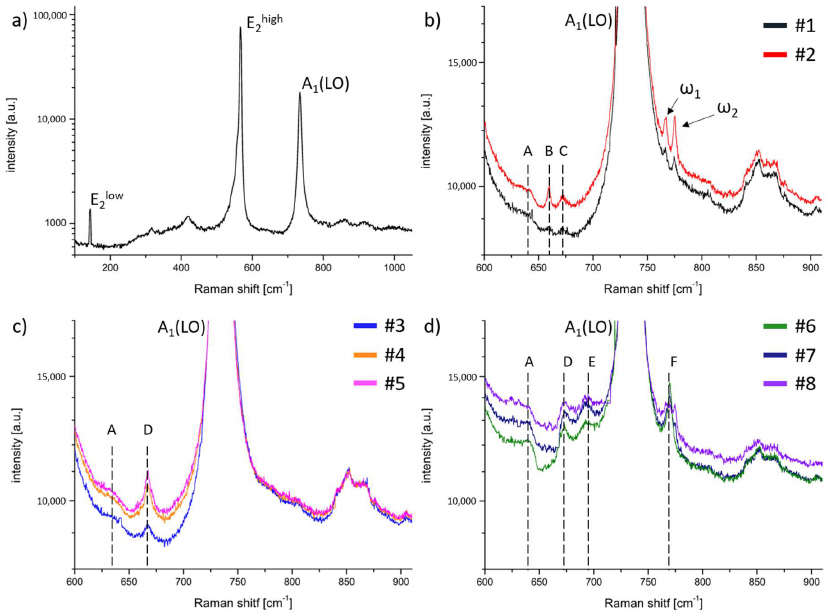
Figure 2. Raman spectra for ( a ) UID-HVPE-GaN; ( b ) HVPE-GaN:C; ( c ) HVPE-GaN:Mn; and ( d ) HVPE-GaN:Mn,C collected at ambient conditions in z ( xx ) z